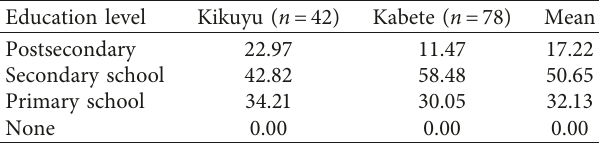
Table 2: Education level of broiler farmers in the study area (%).